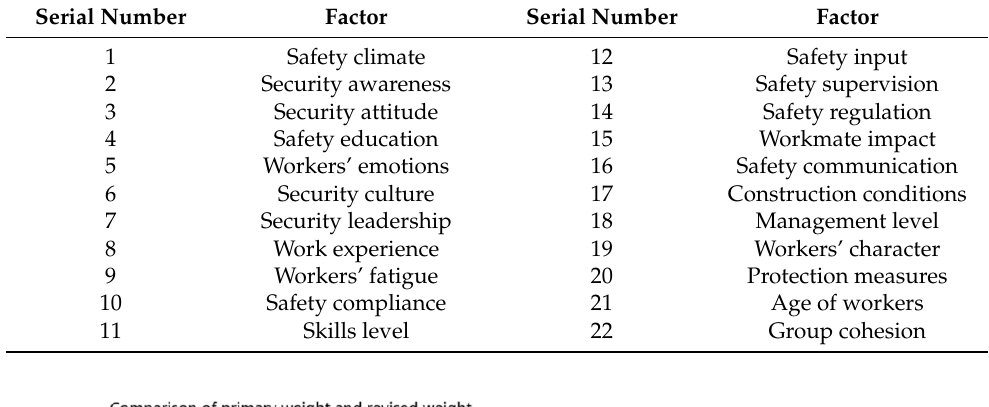
Table 14. The serial number of factors.